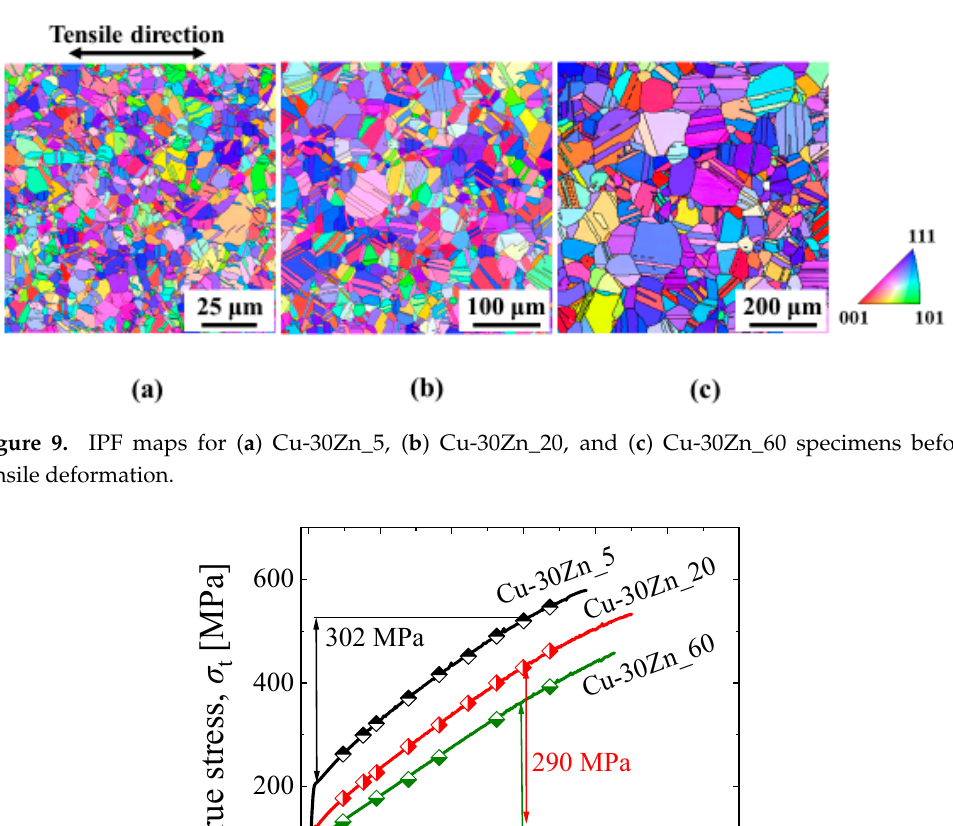
(b) Figure 11. ( a ) Variations of dislocation density and M with respect to true strain [22]; ( b ) M as a function of dislocation density. 3.3. Effect of SFE on the Variation in M valUe To investigate the effect of SFE on the extent of dislocation rearrangement, recrystallized pure Cu (SFE = 78 mJ/m 2 [24]) was tensile deformed, and the variation in the obtained M values was compared with those of Ni (SFE = 149 mJ/m 2 [18]) in Figure 8. The mean grain size of the Cu specimen was approximately 20 μ m, which is half of that for the Ni specimen. However, the difference in grain size did not influence the dislocation rearrangement, as demonstrated in Section 3.2. Therefore, we may assume that the difference in M values between Ni and Cu specimens only represents the effect of the corresponding SFEs. Figure 12 shows the variations in the M values of the Ni and Cu specimens with respect to the dislocation density. The M values of Ni and Cu specimens fitted the same curve despite the large difference between their SFEs. Thus, the difference in SFE also had a negligible influence on the extent of dislocation rearrangement.